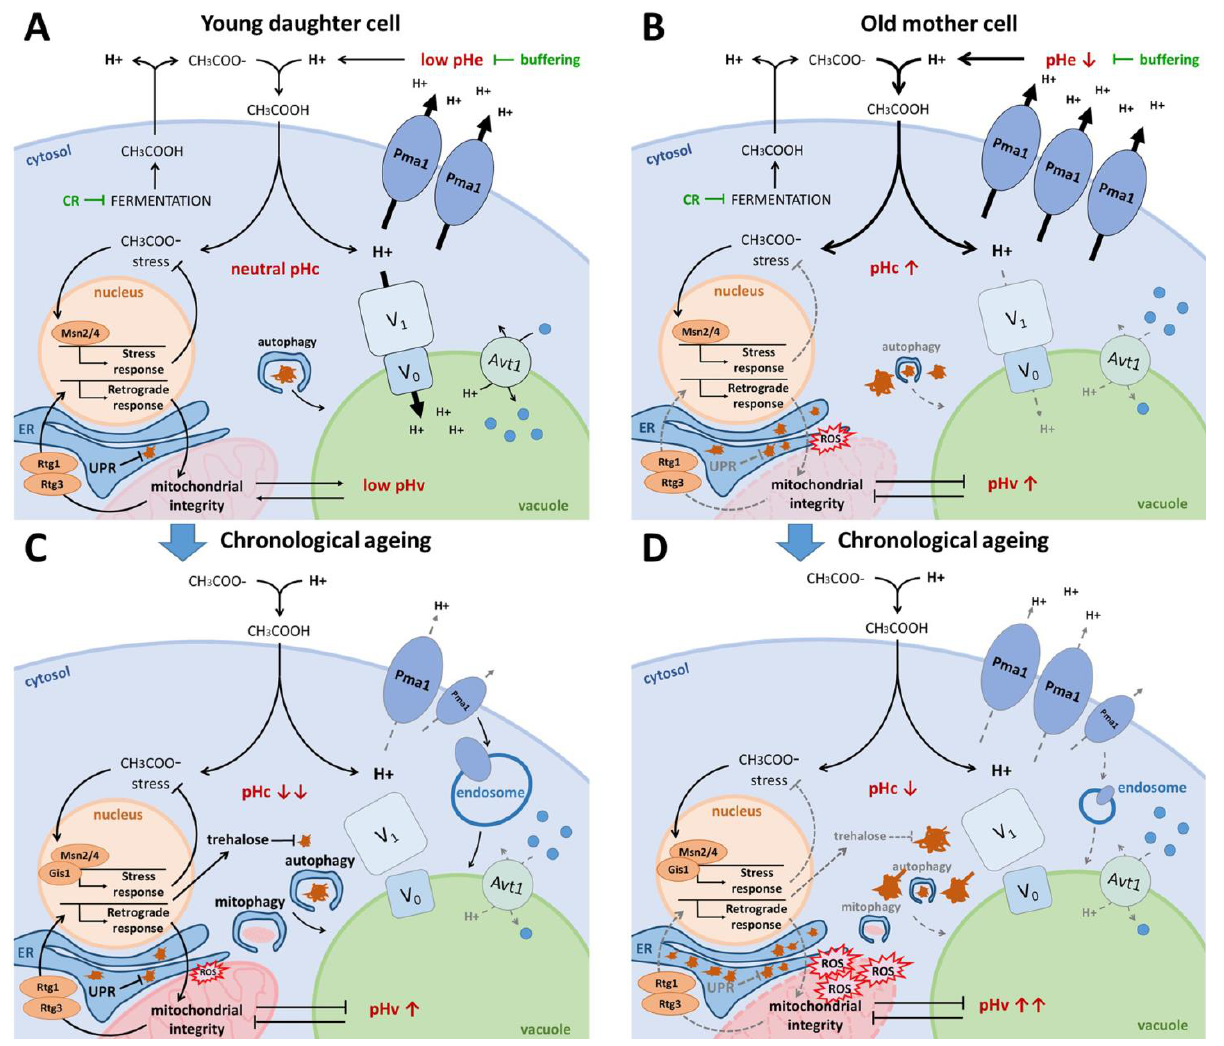
FIGURE 3: The interplay between pH control and ageing. ( A) Young daughter cell. Fermentatively growing cells produce acetic acid, which is extruded from the cell. When protonated in the acidic medium, acetic acid passes the plasma membrane causing cytosolic acidification and acetic acid stress. CR and medium buffering counteract this phenomenon by reducing fermentation and protonation of acetic acid respectively. The optimally active Pma1 and V-ATPase retain the cytosolic pH around neutrality by counteracting this proton influx. The resulting acidic vacuole allows for optimal amino acid uptake by the proton/amino acid antiporter Avt1 and efficient autophagy. Acetic acid stress induces the environmental stress response aided by transcription factors Msn2/4. Albeit mitochondria are not required for energy production on fermentative medium, they do contribute to the maintenance of pH homeostasis. The retrograde response, mediated by Rtg1/3, assures mitochondrial integrity. In the event of protein misfolding, the UPR is activated in the ER. Damaged and aggregated proteins are efficiently cleared by autophagy and the ubiquitin-proteasome system (UPS; not shown). (B) Old mother cell. Due to asymmetrical inheritance, mother cells possess an abundance of Pma1 proteins, presumably raising the cytosolic pH, which likely also causes an unavailability of protons to be traversed to the vacuole. The resulting vacuolar alkalization causes insufficient amino acid import by Avt1, leading to mitochondrial dysfunction by a yet unknown mechanism. The retrograde response is activated in an attempt to counteract mitochondrial dysfunction, though it may not be sufficient to maintain mitochondrial integrity. Misfolded proteins accumulate in the ER thereby triggering ER stress, and damaged proteins accumulate in the cytosol due to impaired autophagy and an overwhelmed UPS (not shown). Both reduced mitochondrial integrity and protein misfolding lead to the formation of reactive oxygen species (ROS) and they affect lipid homeostasis thereby further impairing vacuolar functioning. (C) Chronological ageing of young daughter cell. When traversing the diauxic shift, cells experience a disassembly of the V-ATPase and a reduction in Pma1 activity, aided by its endocytosis. As a result, the cytosol acidifies and the vacuole alkalizes. This presumably, similar as in replicatively ageing cells, leads to an impairment of vacuolar amino acid uptake, autophagy, mitophagy and endocytosis. In post-diauxic shift cells, Msn2/4 and Gis1 are activated to induce stress responses and the production of trehalose, which helps to protect cells from acetic acid stress and toxicity of damaged proteins. Although stress responses are optimal in young daughter cells traversing post-diauxic shift, intracellular damage will accumulate over time, eventually surpassing the capacity of the protective machinery, leading to cell demise. (D) Hypothetical model of chronological ageing in old mother cell. In this model we assume a cumulative deregulation of the already decontrolled pH homeostasis in old mother cells following post- diauxic shift. This should lead to an additional impairment of vacuolar amino acid uptake, autophagy, mitophagy and endocytosis and cause a quick accumulation of intracellular damage, leading to more rapid cell OPEN ACCESS | www.microbialcell.com